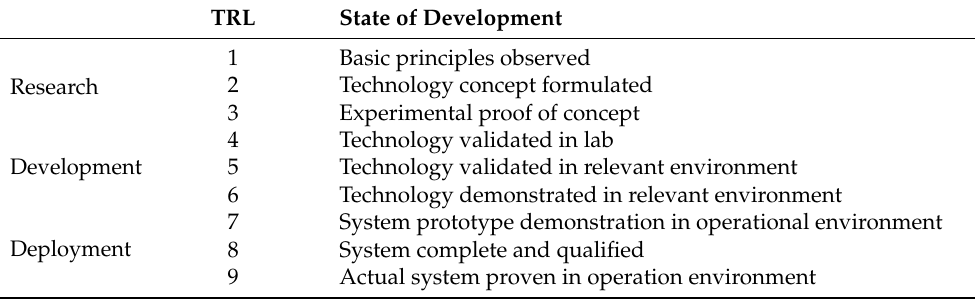
Table 1. Technology readiness level.